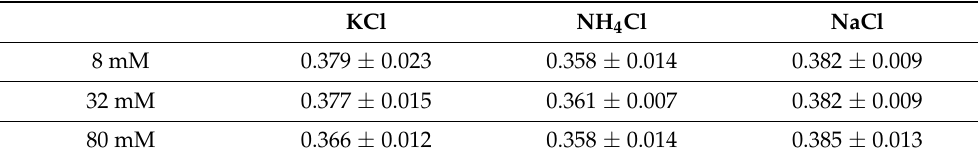
Table 2. Algal biomass (dry biomass, g L − 1 ) changes with different salt concentrations. The initial concentration was 0.370 g L − 1 .